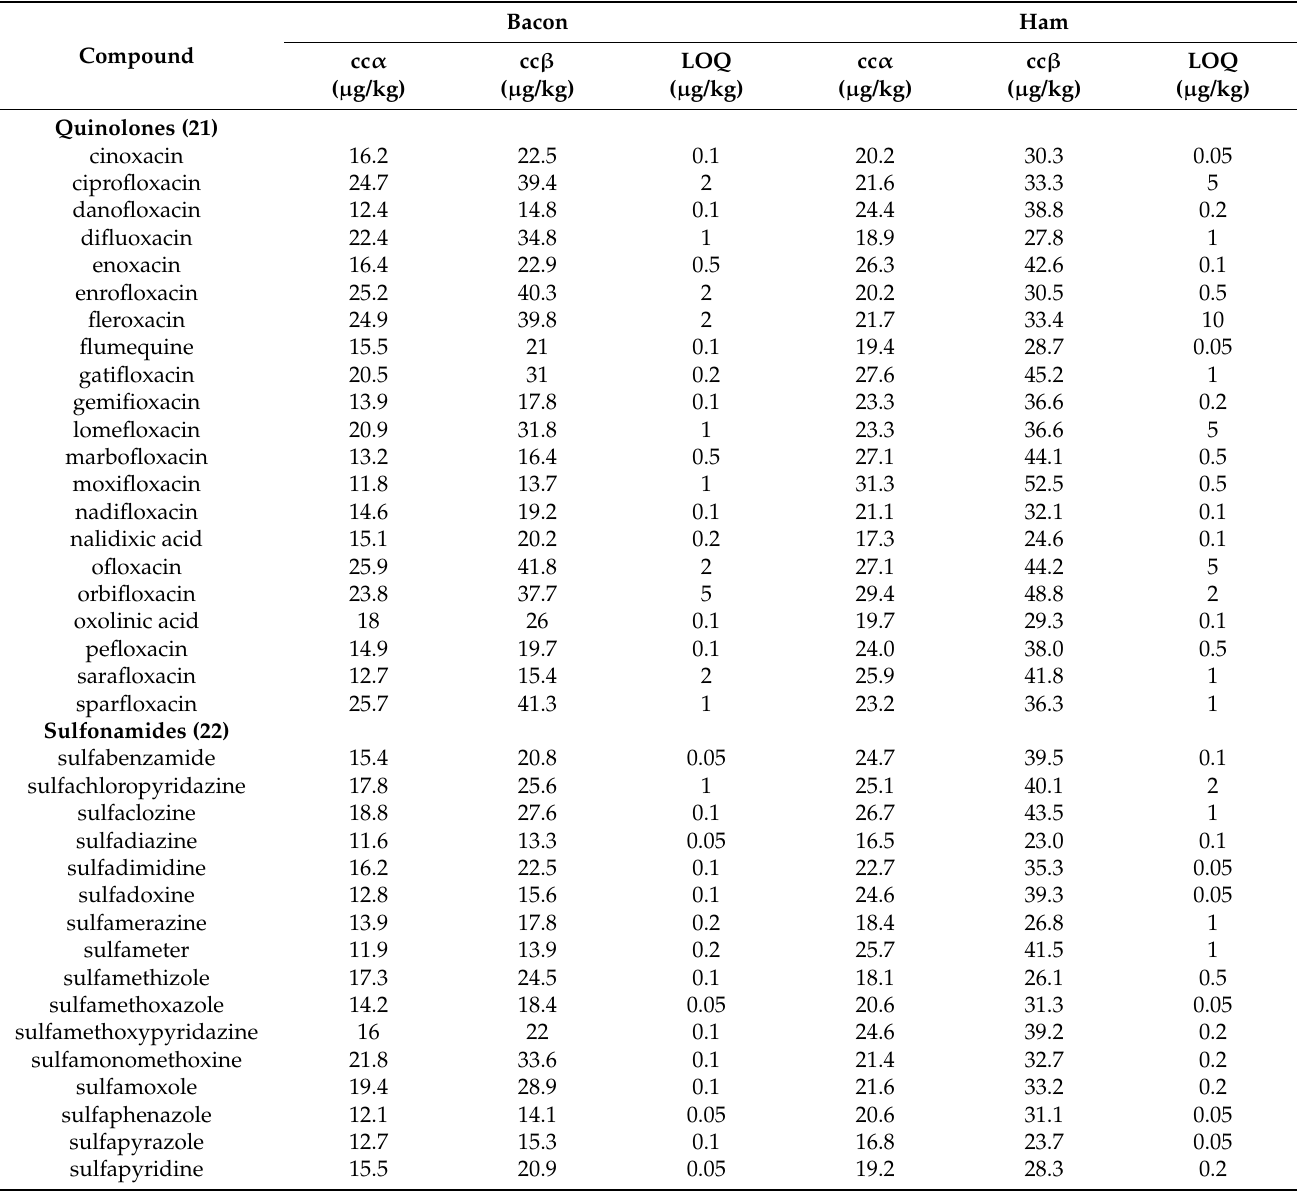
Table 2. Validation parameters for the developed UPLC-MS/MS